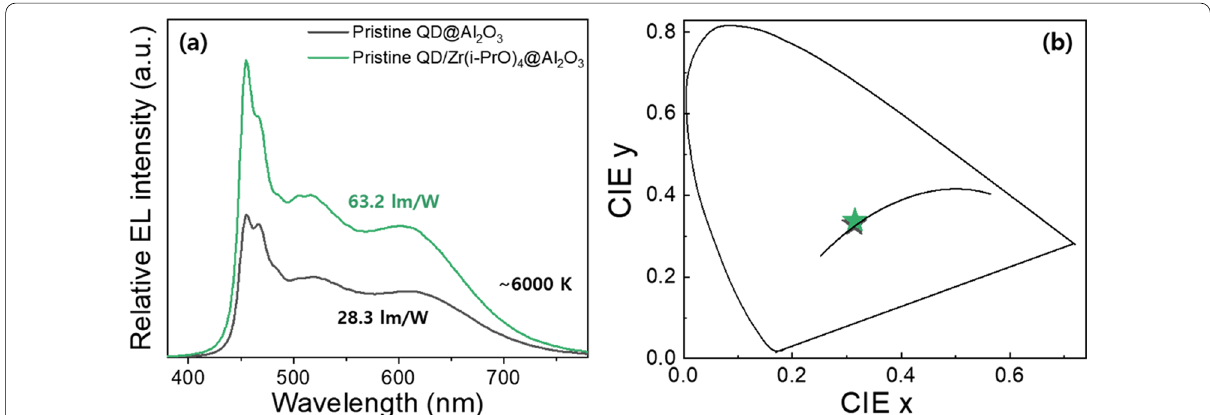
Fig. 10 a EL spectra and b CIE color coordinates of two correlated color temperatures (CCTs) of fabricated pristine QD@Al 2 O 3 and pristine QD/